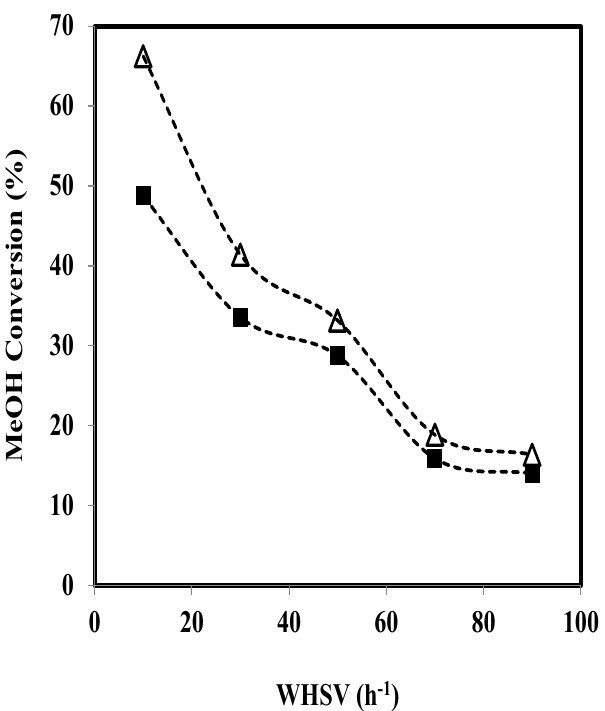
Fig. 3. Methanol conversion versus WHSV at 290 o C and 320 o C (∆) in the fixed bed reactor for catalyst particle size of 0.5<P.S. .<1mm. Dotted lines show the trend of changes